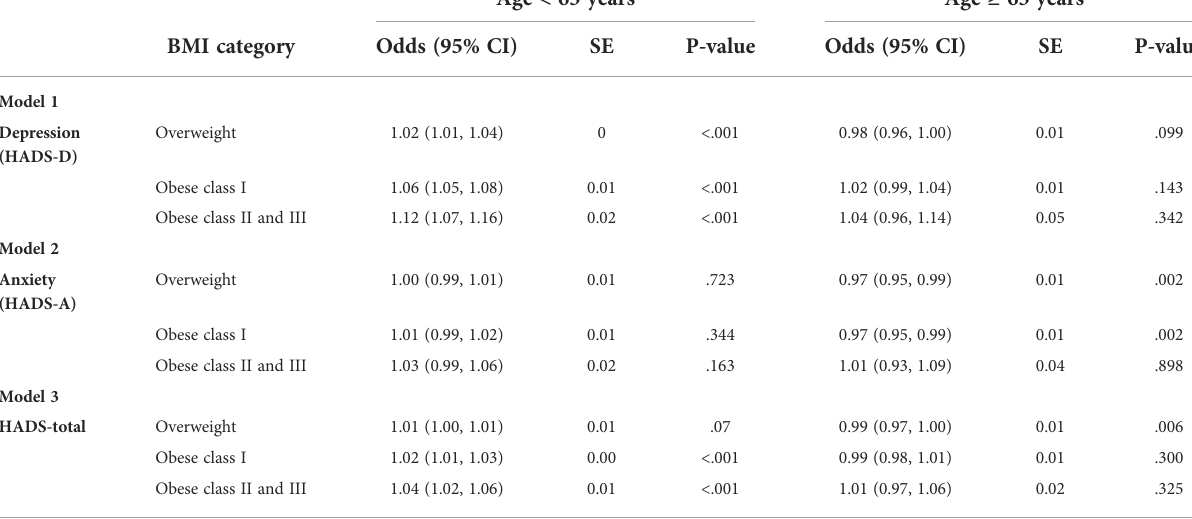
TABLE 3 Odds of BMI category considering symptoms of depression and